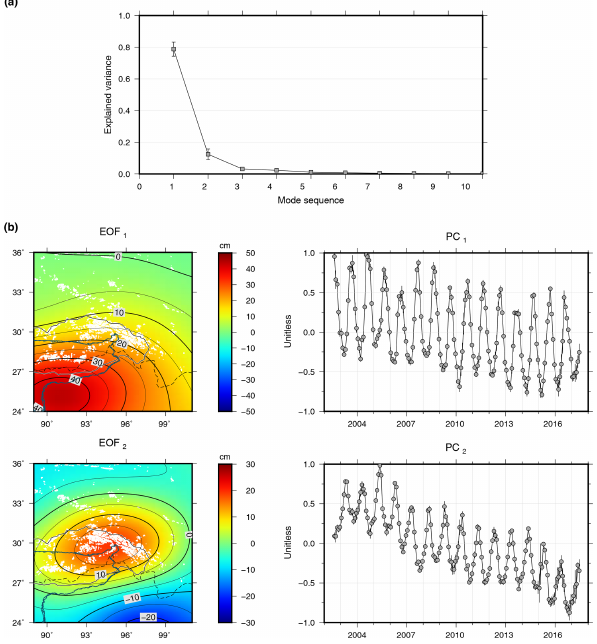
Figure 3. EOF decomposition of GRACE observations in the form of EWH in the study region. Six combinations are averaged to gen- erate these plots, and uncertainties are estimated based on the dis- persions. (a) Weight of the first 10 components. (b) Spatial distribu- tion (EOF) and temporal variation (PC) in the first two components. The white shaded areas represent glacier